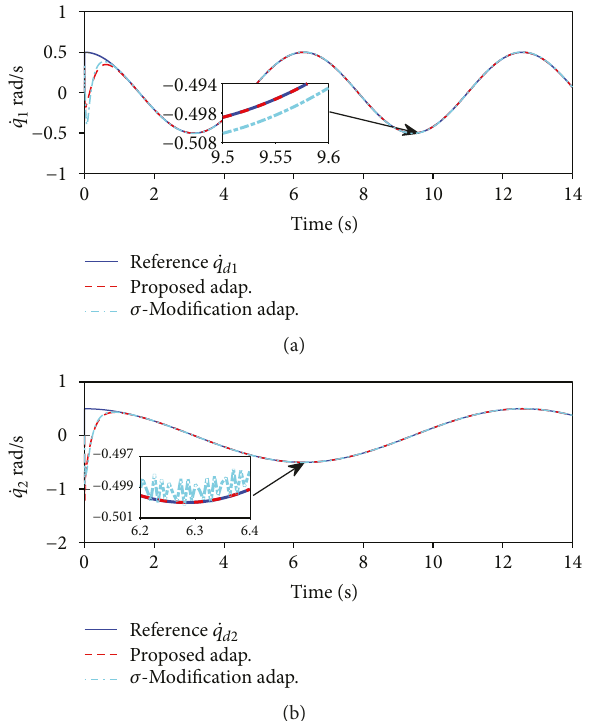
Figure 5: Tracking performance of robotic joint velocity q